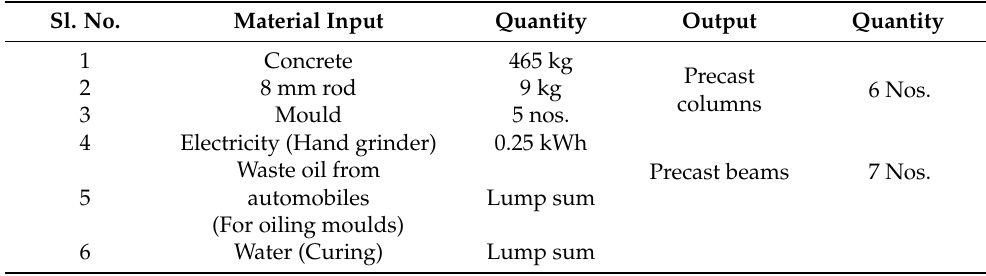
Table 7. Inventory details of Phase D—Casting of precast beams and columns. Sl. No.